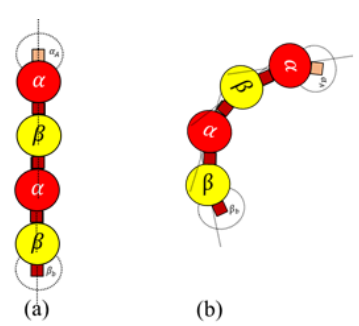
Figure 7. ( a ) Bonding between active dimers for protofilament formation (Rule 3a and Rule 4); ( b ) Bonding between active dimers for ring formation (Rule 3b and Rule